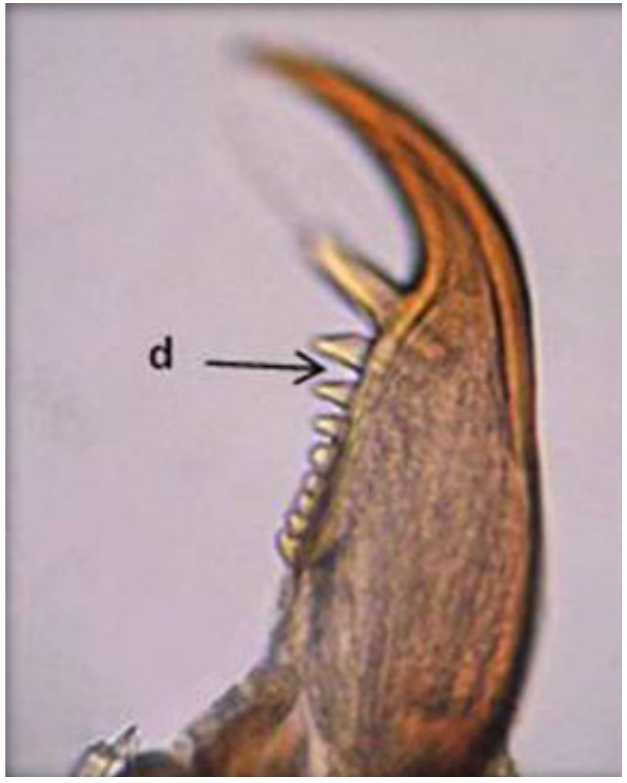
B. huaico Figure 4. Nymph of . (d) denticles, tarsal claws, lateral view.